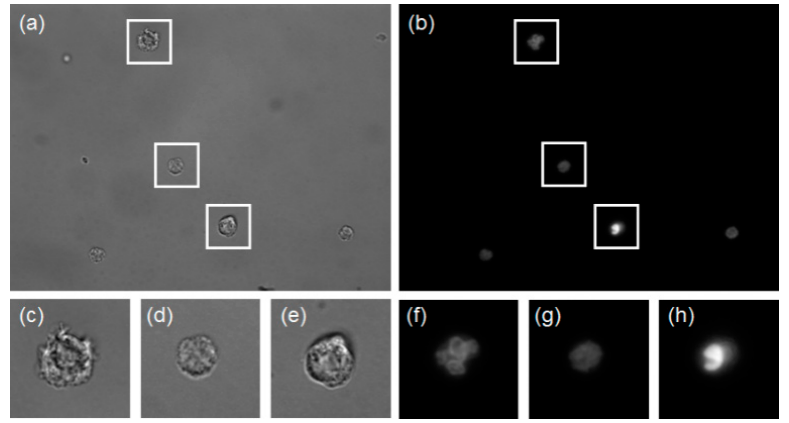
Figure 1. White blood cells (WBC) images taken by microscope ( a ) bright-field WBC images, ( b ) the corresponding fluorescent WBC images, ( c – e ) bright-field granulocyte, lymphocyte, and monocyte images, ( f – h ) the corresponding fluorescent granulocyte, lymphocyte, and monocyte images.